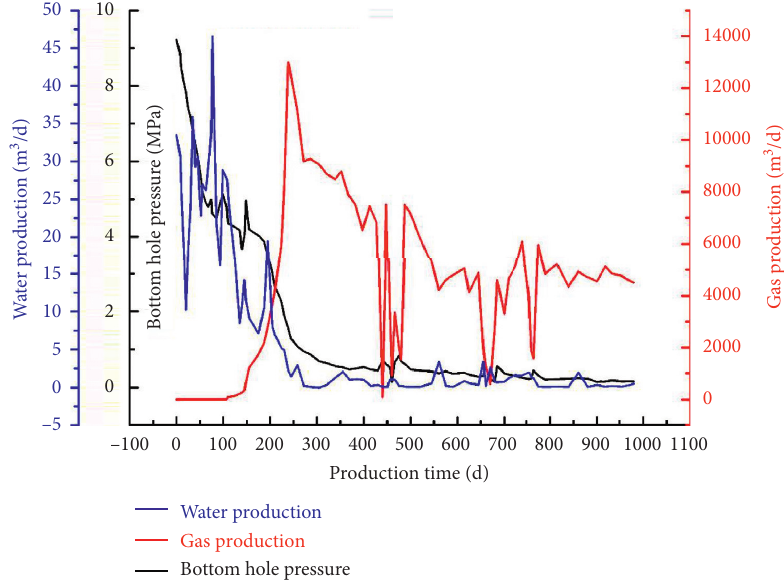
Figure 7: Production curve of well